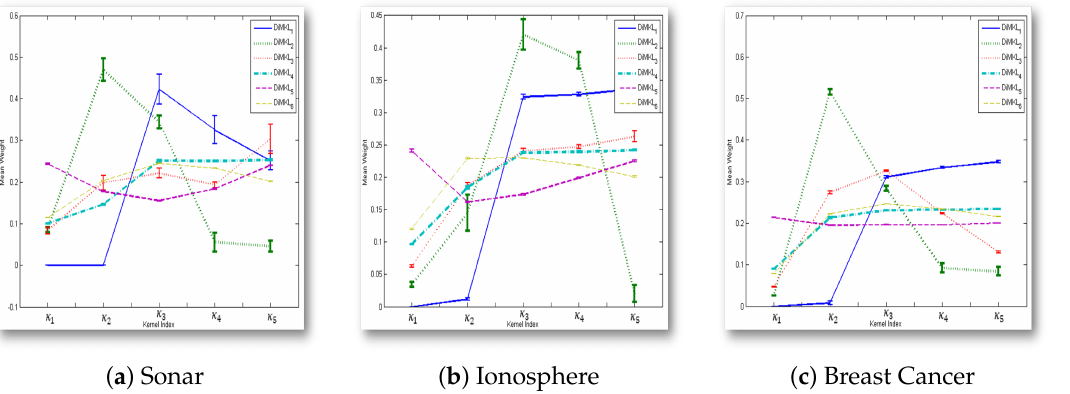
Figure 4. Mean weights and standard deviations (error bars) for each individual kernel for the six proposed heuristic MKL weight assignment equations.